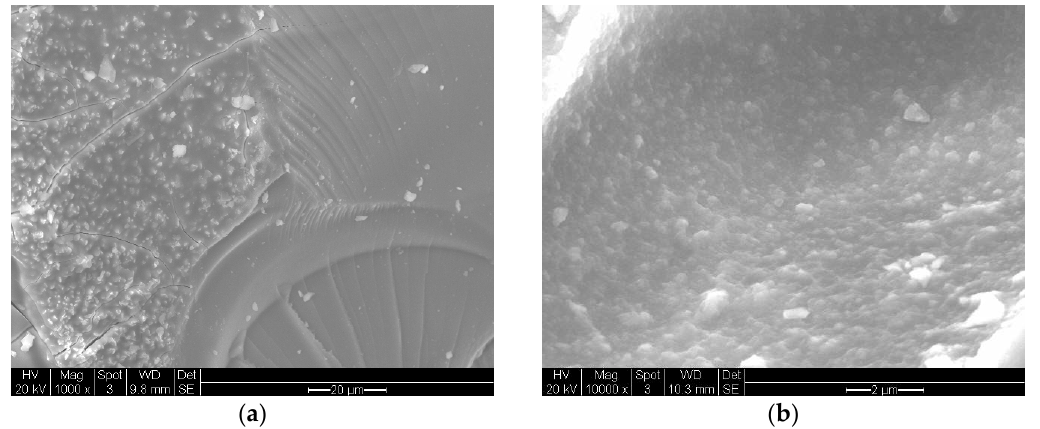
Figure 20. Scanning electron microscopy of the catalyst Fe/Si = 1/4 Ph-washed, supported catalyst obtained after UV irradiation (intensity LUX = 82,000 lx) for 120 h at 25 °C and 50% relative humidity followed by washing in water at room temperature. ( a ) Overall structure (Scale bar = 20 μ m); ( b ) Wall structure (Scale bar = 2 μ m).